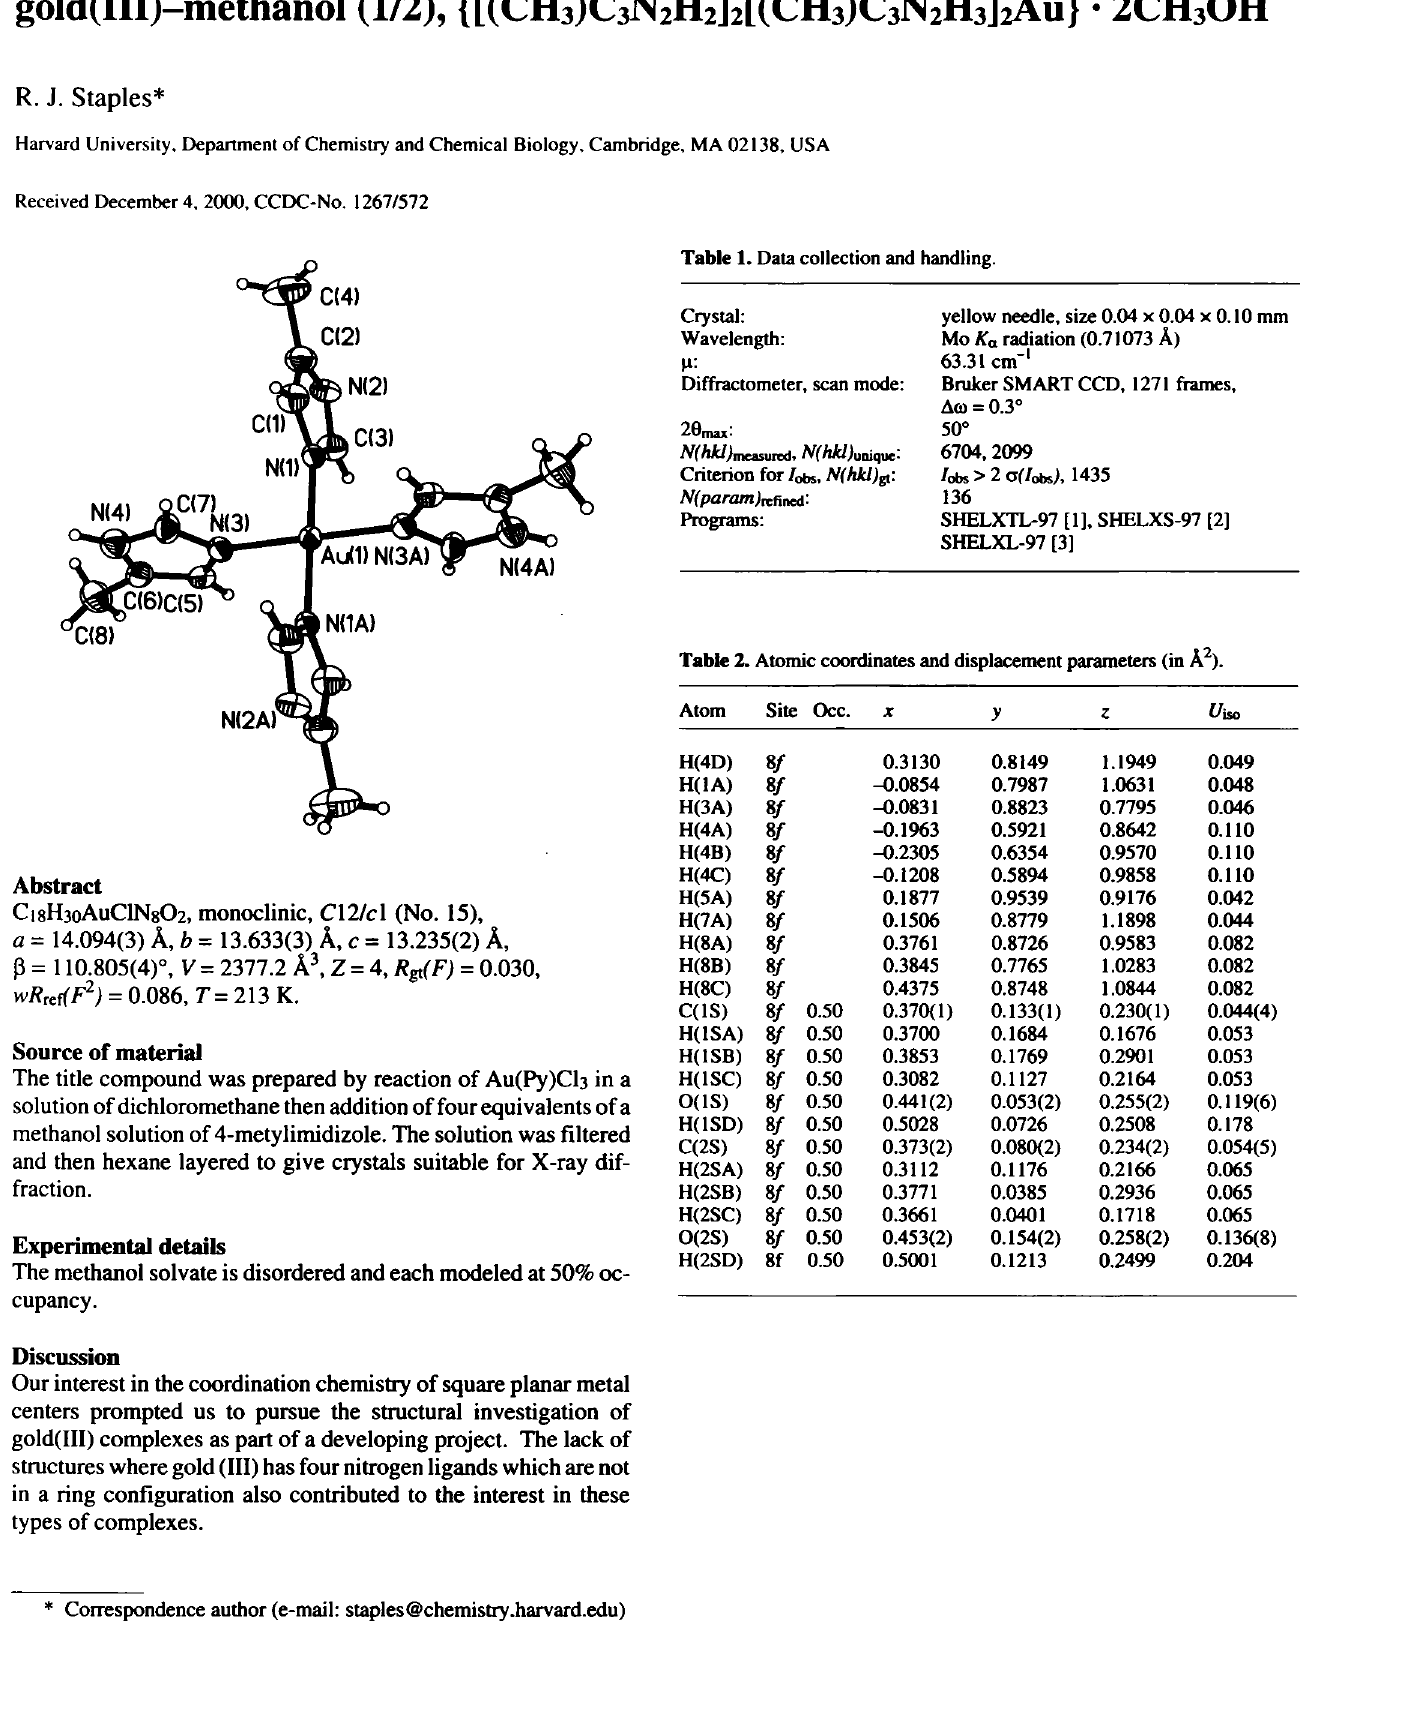
Table 1. Data collection and handling.